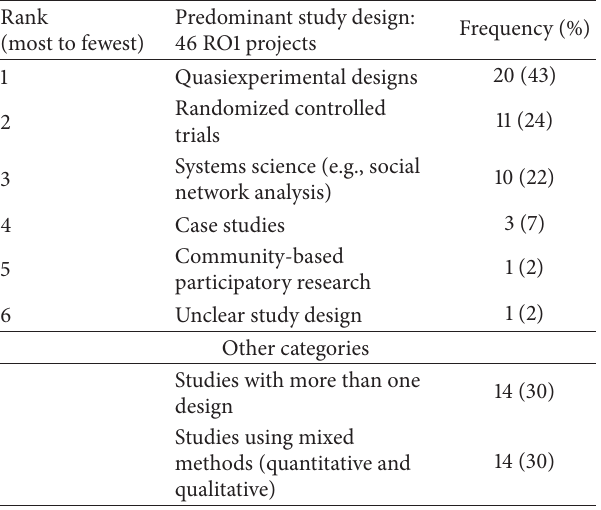
Table 5: Predominant study designs and methods in the R01